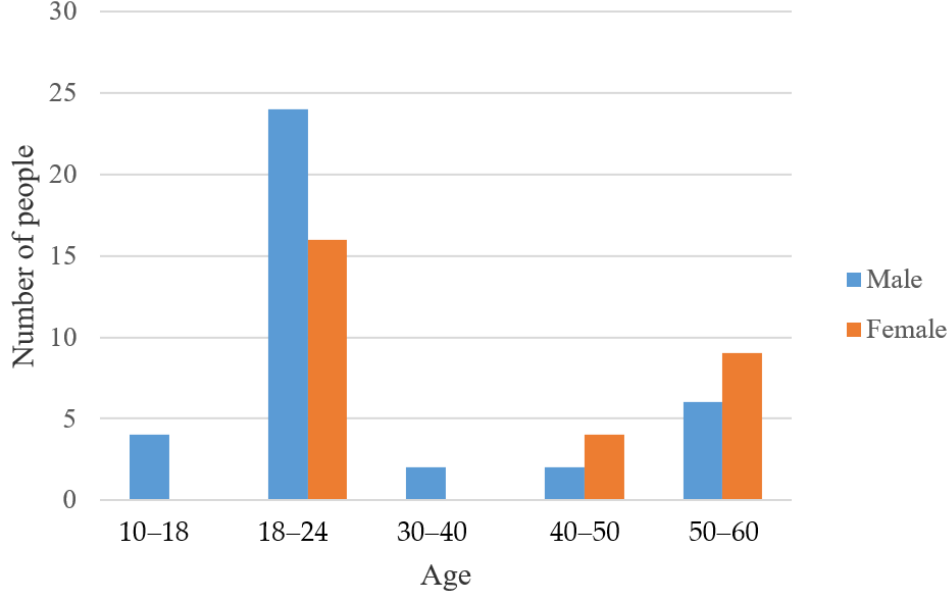
Figure 3. Age and gender of the participants.